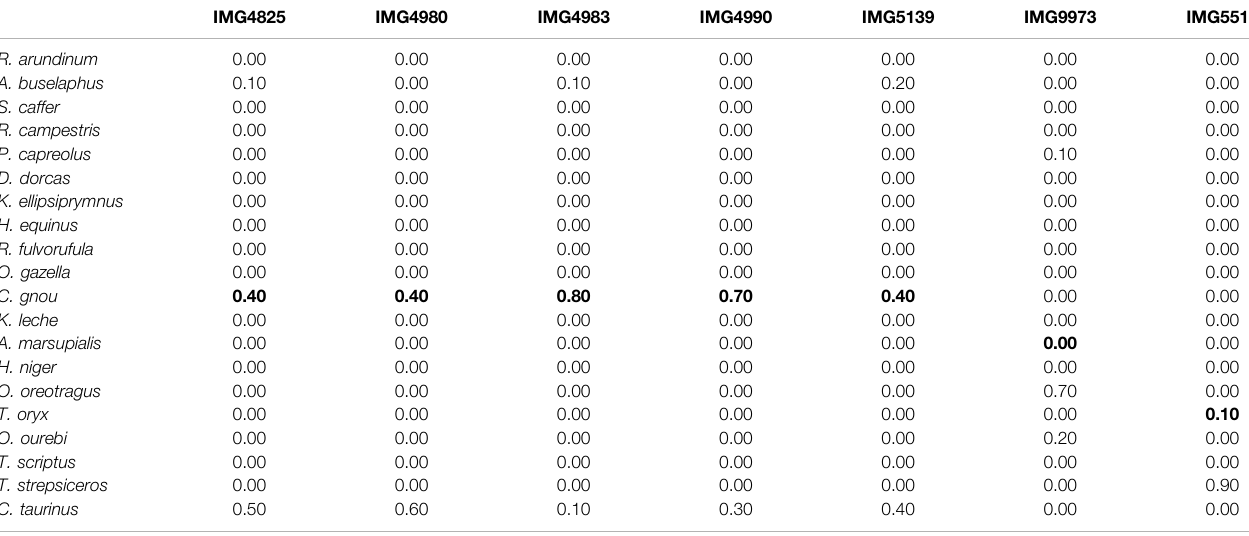
TABLE 4 | Real data . Species level predicted class probabilities with knn classi fi er with k n (cid:2) 10. Emboldened values indicate the “ true ” class as obtained from an expert.